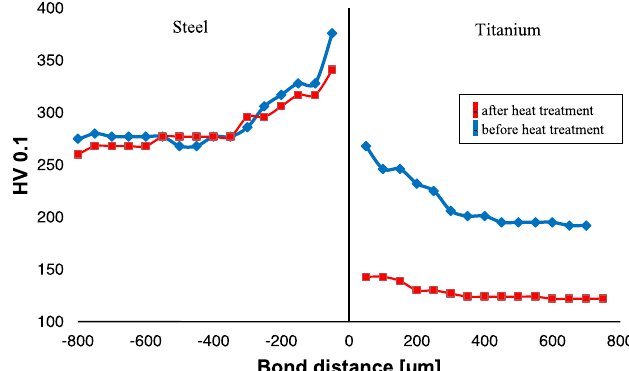
Fig. 8. Microhardness pro fi le of explosively welded bimetal is state before and after the heat